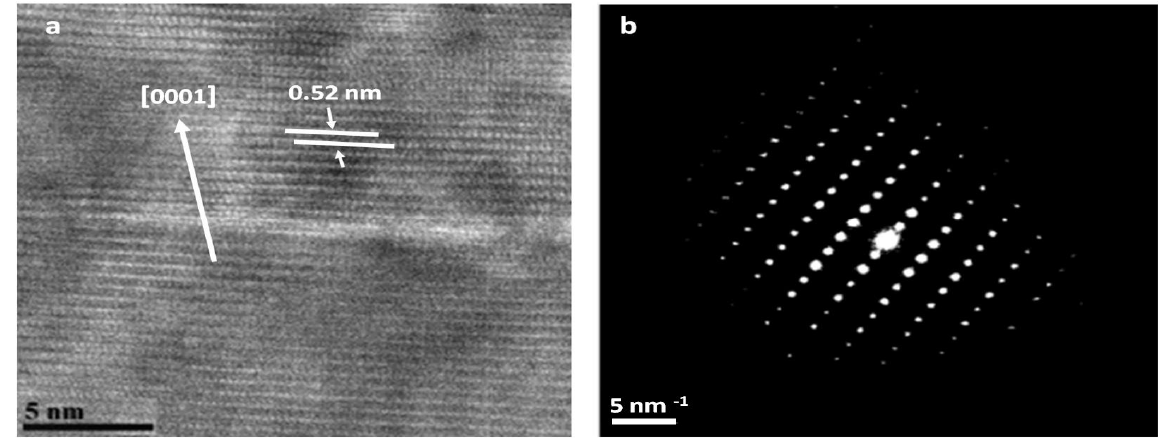
Figure 10. ( a ) high-resolution transmission electron microscopy (HR-TEM) image of ZnO nanowire with (0001) growth direction and ( b ) selected area electron diffraction (SAED) pattern of the nanowire.